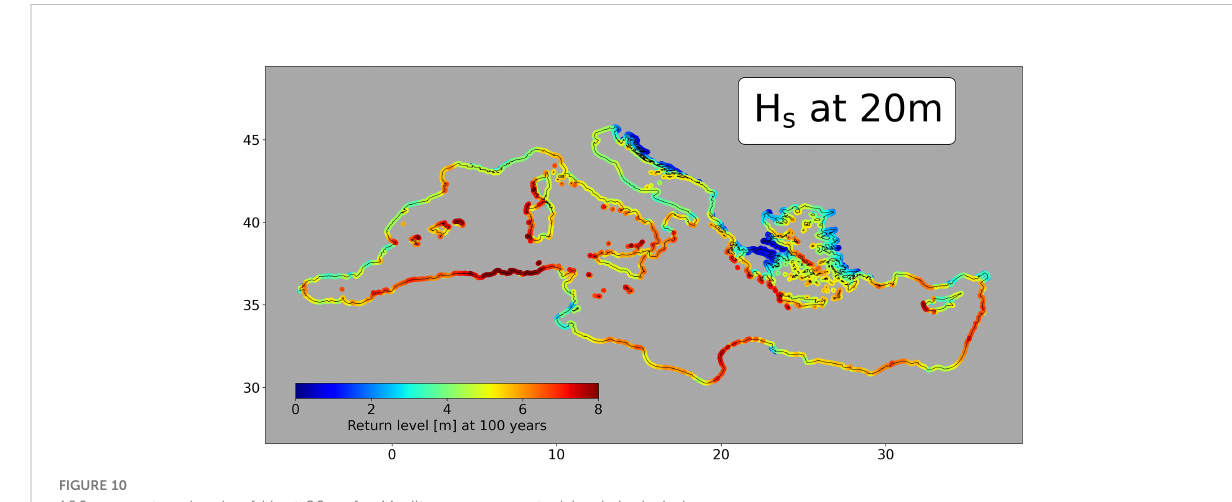
FIGURE 10 100-year return levels of H S at 20 m for Mediterranean coasts, islands included.